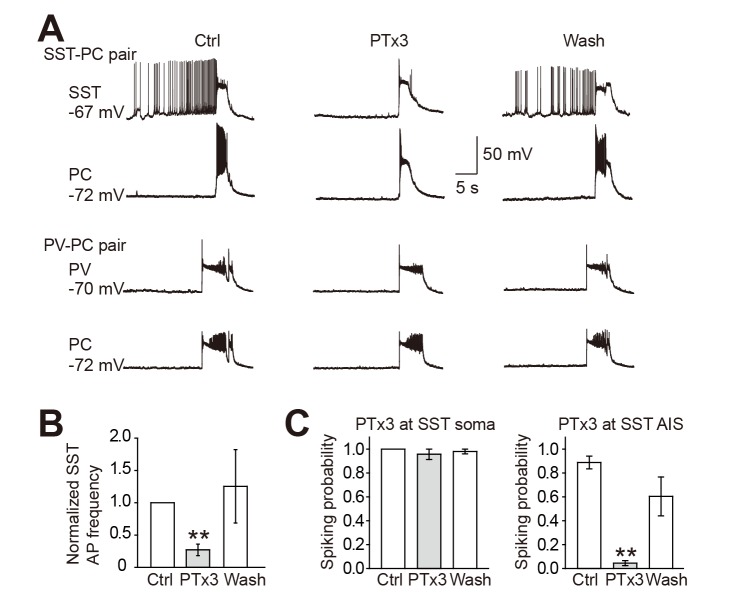
Spontaneous firing in SST neurons were suppressed by PTx3.(A) Example recordings from SST-PC and PV-PC pairs. PC and PV neurons showed no spontaneous activity during the refractory period between network-activity events; however, the SST neuron was constantly active. Spontaneous APs in the SST neuron could be substantially suppressed by bath application of 30 nM PTx3. (B) Group data showing that 30 nM PTx3 significantly decreased the frequency of spontaneous APs in SST neurons. (C) Puffing PTx3 (300 nM) at the soma had no effect on discharge probability in SST neurons (left), whereas puff at the AIS substantially decreased the firing probability (right). For (B) and (C), paired t test, ** p<0.01. Error bars represent s.e.m.